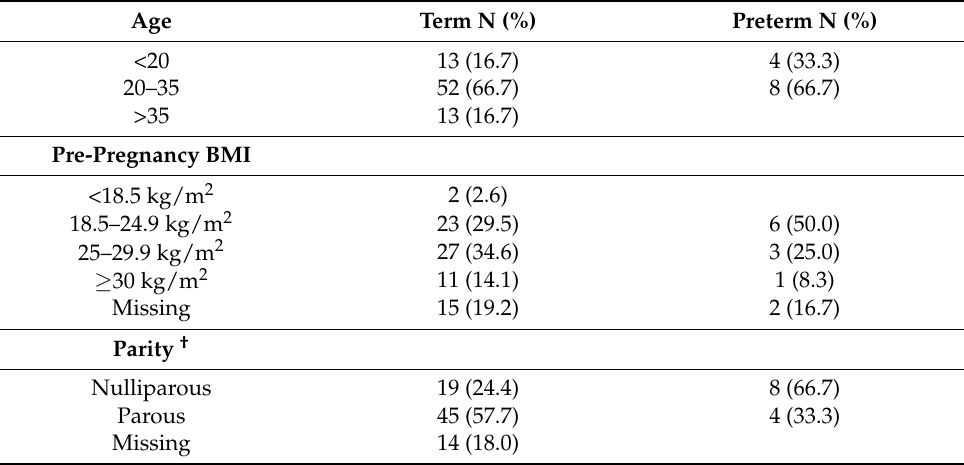
Table 1. Demographic and obstetric characteristics of Mexican women who delivered term (N = 78)